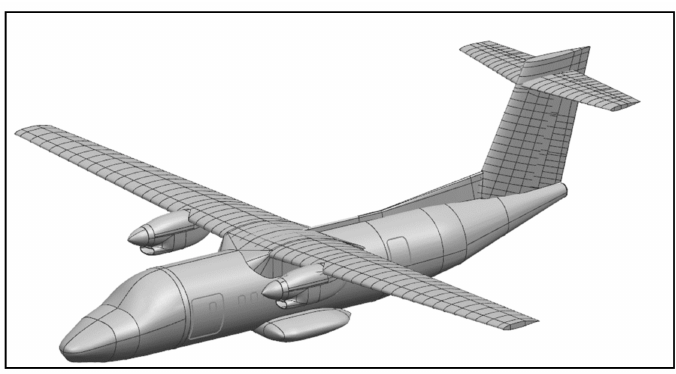
Figure 6. General view of geometry model of investigated